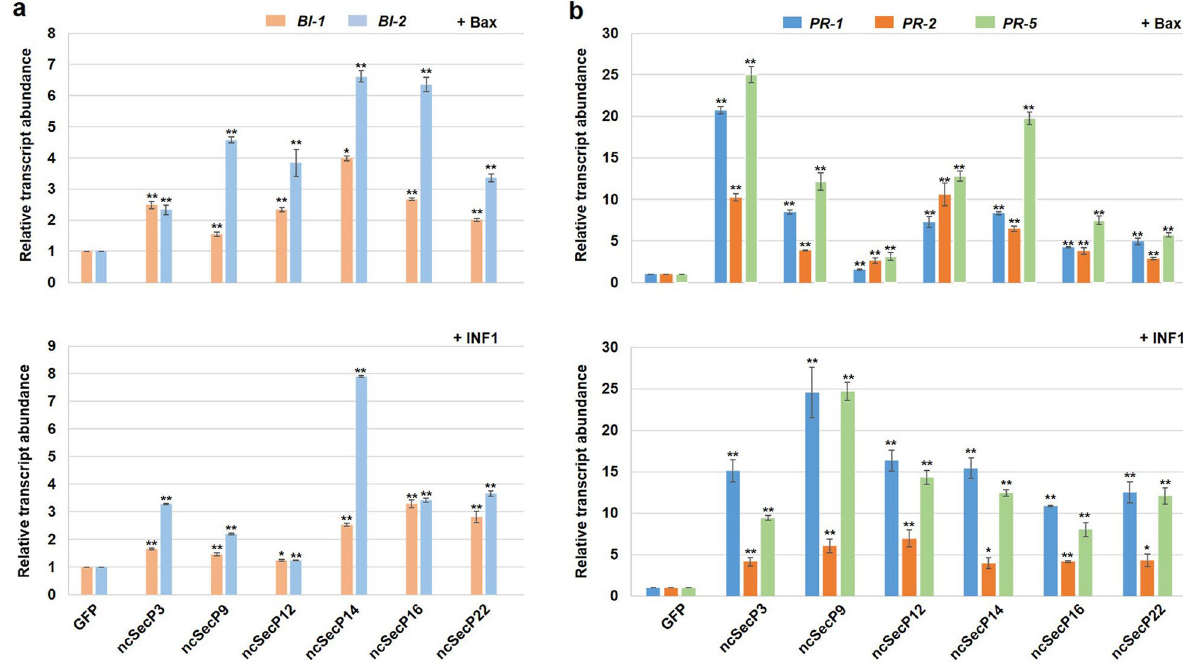
Fig. 5 The HR-suppressing Pzi-ncSecPs enhanced gene expression of cell death inhibitors in Nicotiana benthamiana . The N. benthamiana leaves were individually inoculated with the agrobacterial cells bearing the Pzi-ncSecP or the GFP genes, and further challenged with Bax or INF1 at 24 h post-inoculation (hpi). The leaves were harvested at 24 h post- Bax or INF1 infiltration, followed by the total RNA extraction. The relative transcriptional levels of three pathogenesis-related genes ( NbPR-1 , NbPR-2 , and NbPR-5 ) (a) and two Bax inhibitor-1 genes ( NbBI-1 and NbBI-2 ) (b) were analyzed by using RT-qPCR. Three biological replicates were performed, each with three technical replicates. The N. benthamiana actin gene was employed as the internal reference. Bars indicate the standard errors of the mean, and asterisks show statistically significant differences based on Student’s t- tests (*, P < 0.05, **, P <